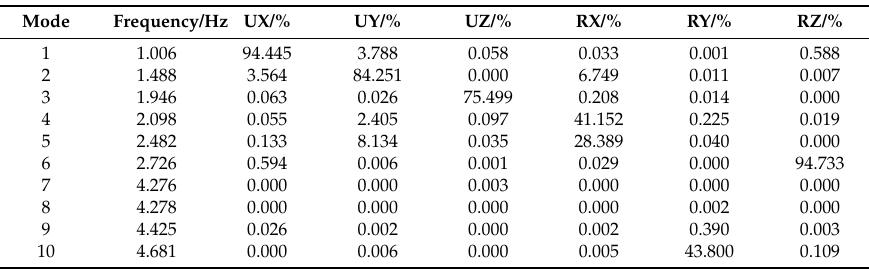
Table 4. Modes of the pedestrian